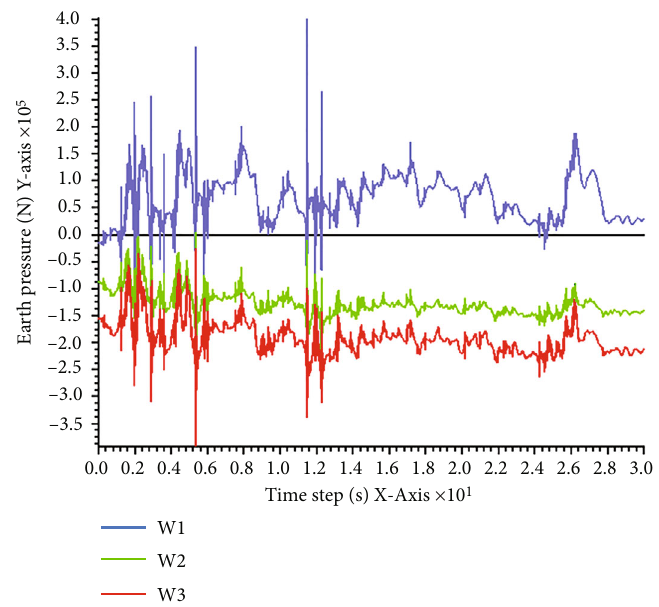
Figure 15: The time-course curve of the earth pressure behind the antislide pile No. 3.